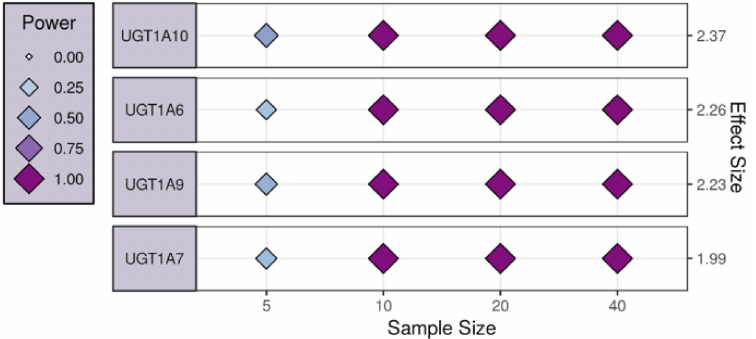
Figure 2. The four identified regulators for the IBD data are represented by the largest observed e ff ect size. The e ff ect size of each assessed variable is shown along the y axis and a series of sample sizes along the x